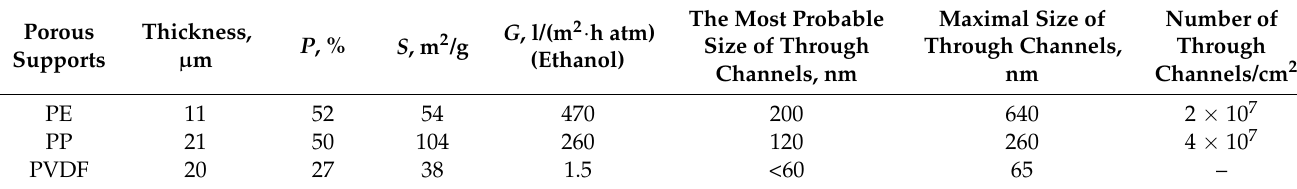
Table 2. Porous structure characteristics of the supports.